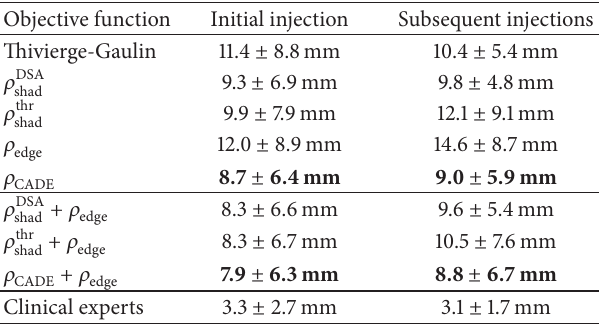
Table 1: Translation errors for all